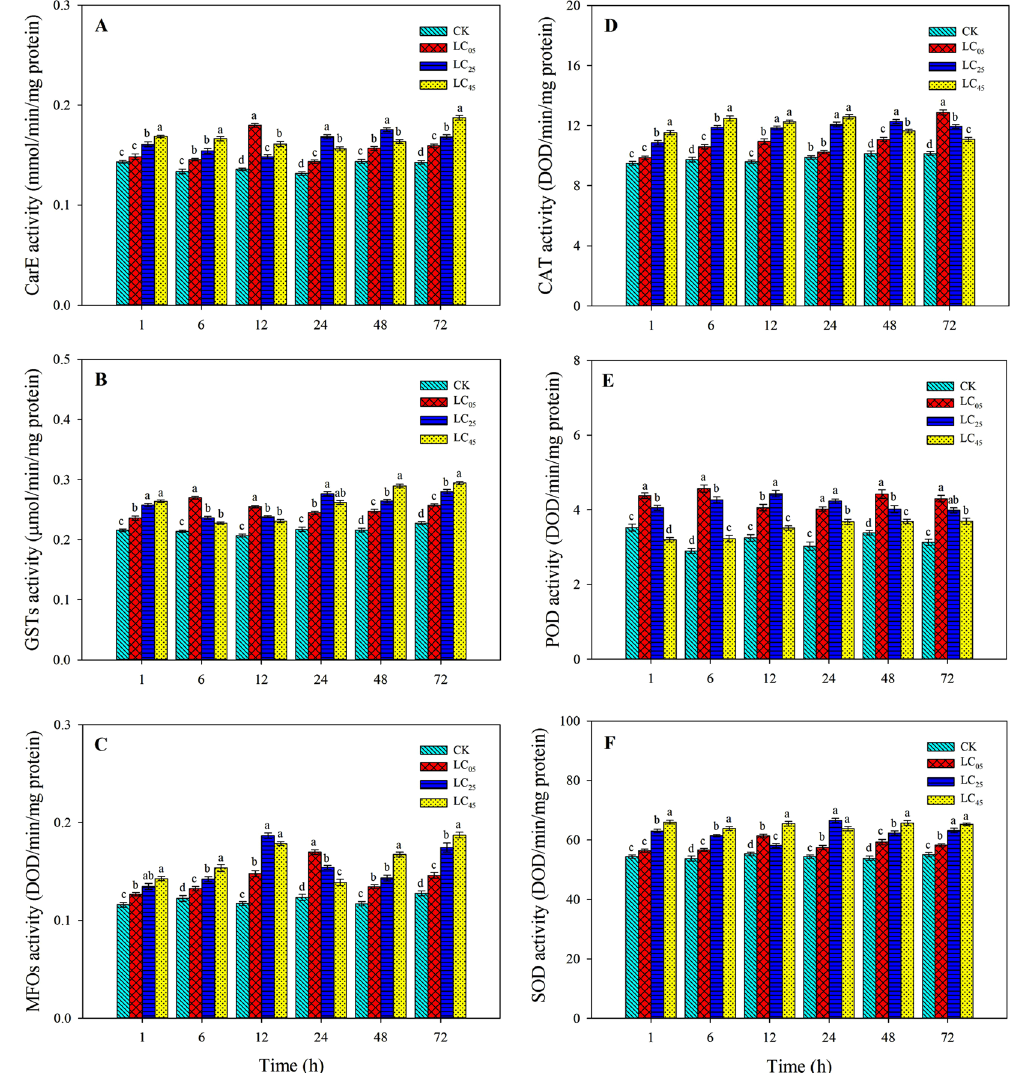
Figure 8. Detoxification enzyme activities ( A ) carboxyl esterase (CarE), ( B ) glutathione S-transferase (GSTs), ( C ) O-demethylation multi-function oxidase (MFOs)) and protective enzyme activities ( D ) catalase (CAT), ( E ) peroxidase (POD), ( F ) superoxide dismutase(SOD)) in third-instar larvae of A. ipsilon (mean ± SE) after exposure to low-lethal concentrations of chlorantraniliprole. Bar with the same lowercase letters indicate no significant differences (Student-Newman-Keuls test, P <